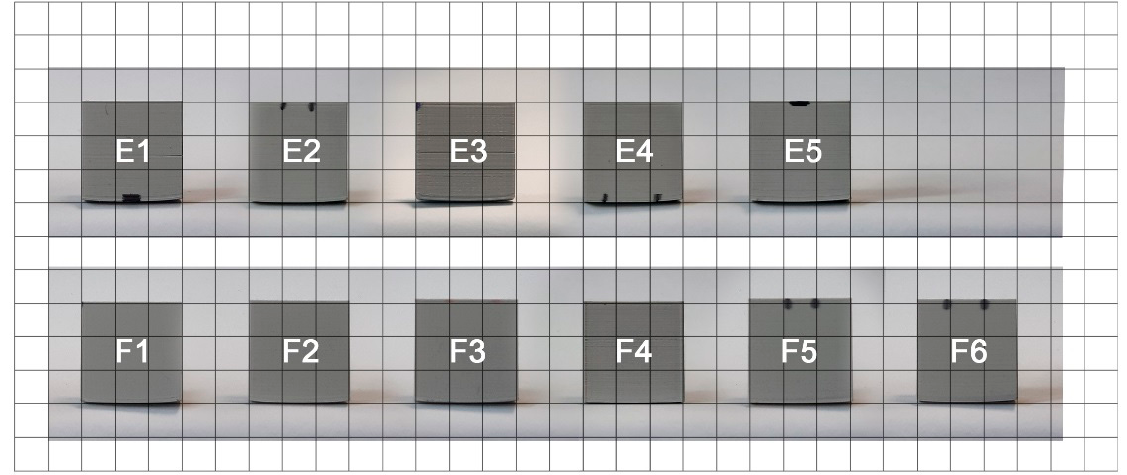
Figure 8. Photos of printed cubes for group D, placed on a 1 × 1 cm 2 grid.